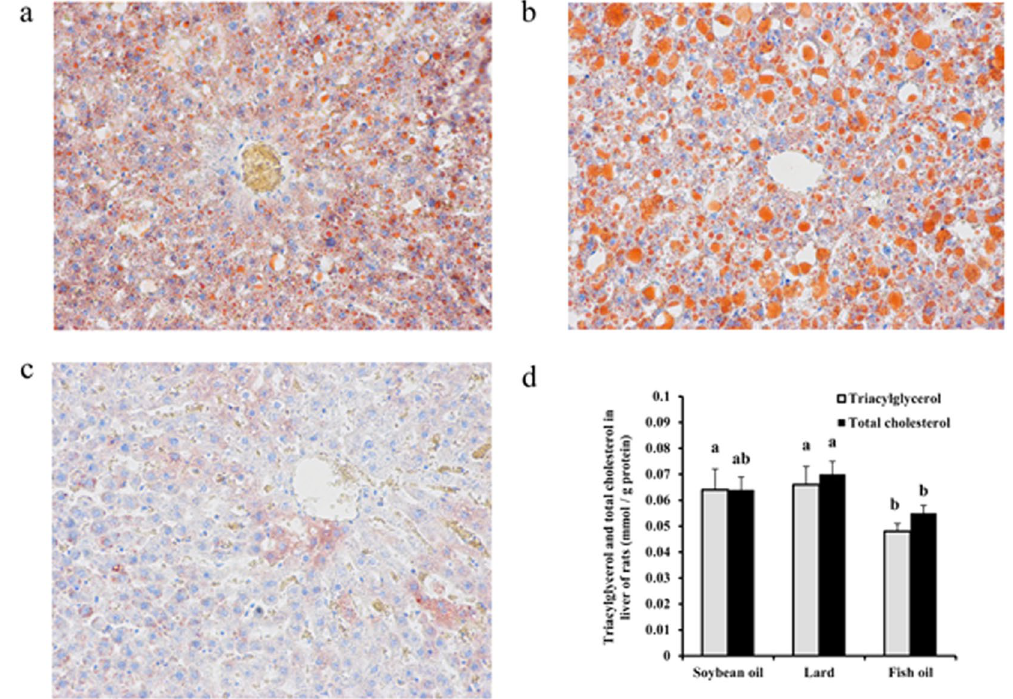
Figure 1. Hepatic fat accumulation of rats fed with soybean oil, lard and fish oil diets. ( a ) Hepatic section stained with Oil Red O from the soybean oil group. ( b ) Hepatic section stained with Oil Red O from the lard group. ( c ) Hepatic section stained with Oil Red O from the fish oil group. Adipocytes were stained red and nuclei were stained blue. (Magnification × 200). ( d ) Hepatic triacylglycerol and total cholesterol. Values are shown as means ± SE (n = 11). Different letters indicate significant difference ( P < 0.05).